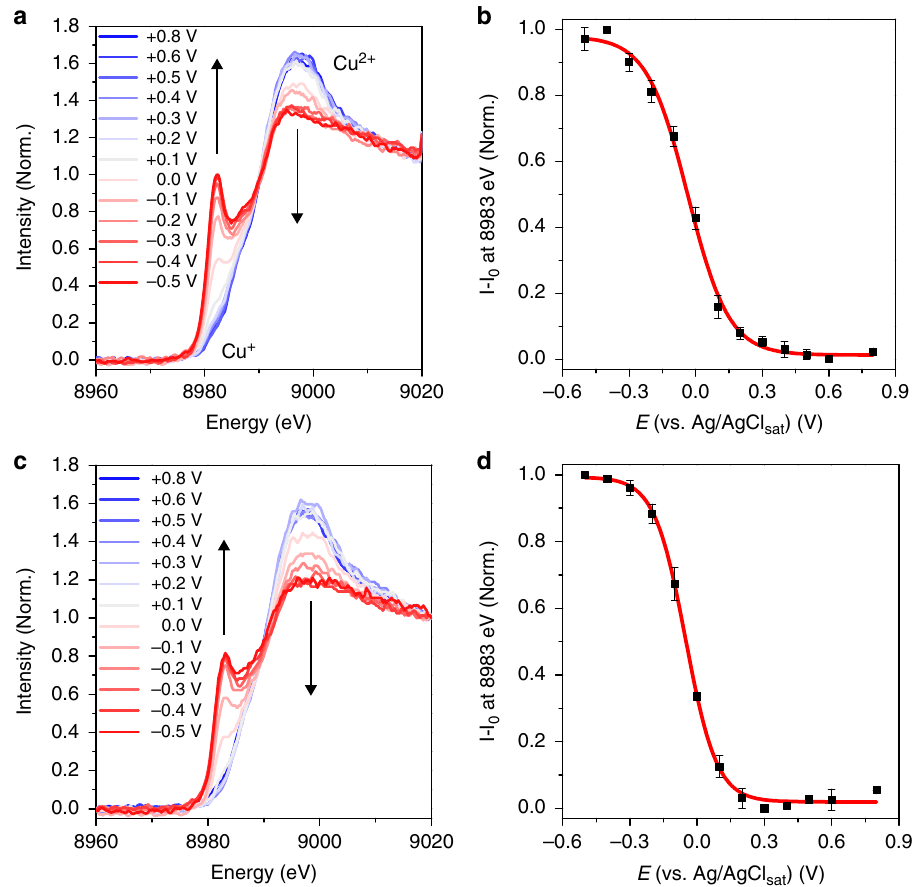
Fig. 3 Cu K-edge XAS spectra under different conditions of electrochemical potential. a XAS spectra in the absence of oxygen. b Evolution of the signal at 8983 eV for reductive titrations in the absence of oxygen. c XAS spectra in the presence of oxygen. d Evolution of the signal at 8983 eV for reductive titrations in the presence of oxygen. Red lines in panels b and d represent the fi ts using the Nernst